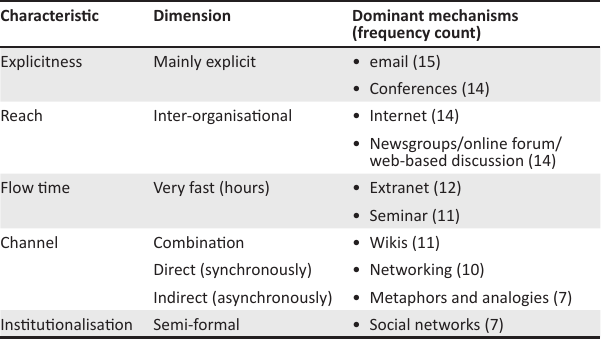
TABLE 13: Cluster 4 main characteristics and dominant knowledge transfer mechanisms.